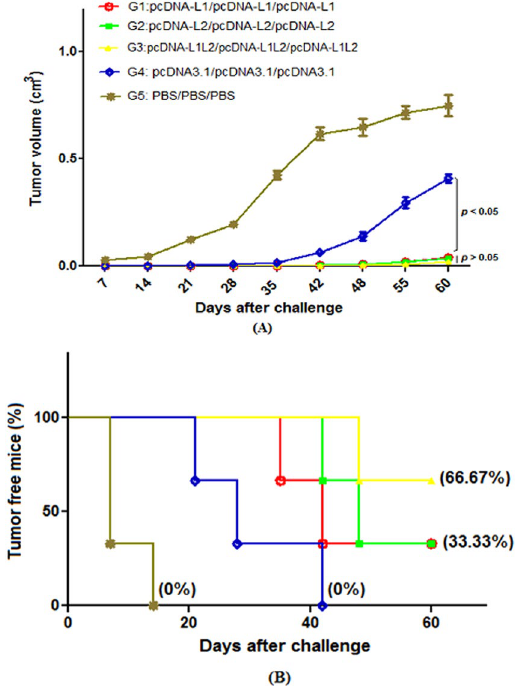
Figure 5. Tumor growth curve and survival percentage in different groups: The mice were challenged with 1 × 10 5 C3 tumor cells two weeks after the last immunization: Tumor volumes were measured twice a week ( A ), the percentage of tumor-free mice (or survival rate) was evaluated in different groups ( B